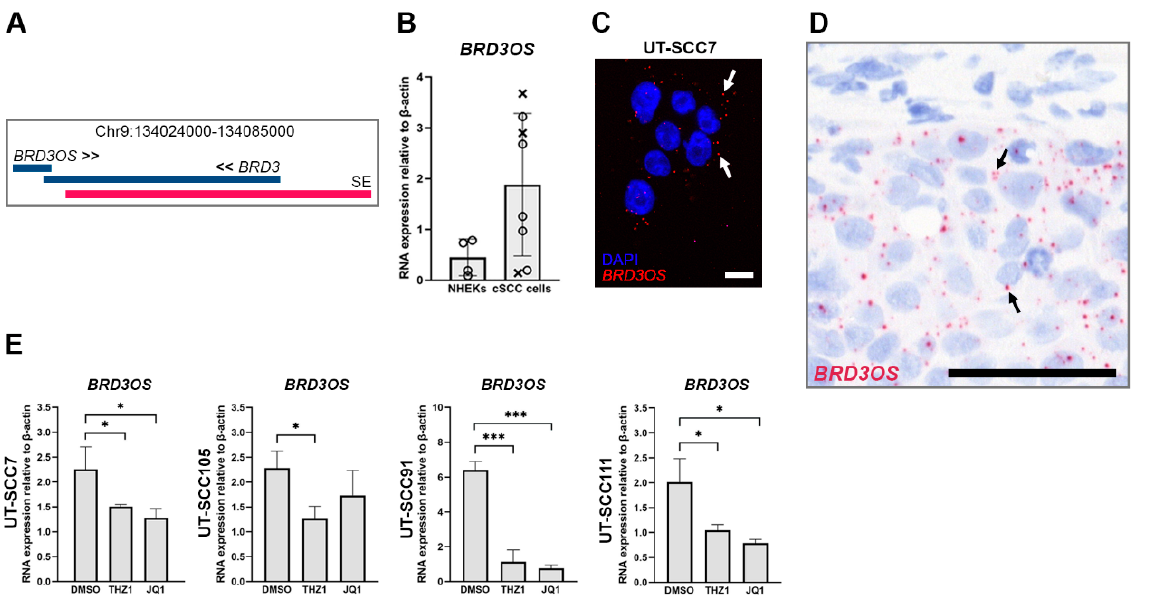
Figure 1. Overexpression of BRD3OS ( LINC00094 ) in cSCC cells is regulated by super enhancer. ( A ) BRD3OS ( LINC00094 ) gene is located near a super enhancer (SE, red bar). ( B ) BRD3OS ( LINC00094 ) expression was measured by quantitative real-time reverse transcriptase PCR (qRT-RCR) in normal human epidermal keratinocytes (NHEKs) ( n = 4) and cSCC cells ( n = 5, primary, round dots; n = 3 metastatic, crosses). ( C ) Expression and cellular localization of BRD3OS ( LINC00094 ) (white arrows) were examined by RNA in situ hybridization (RNA-ISH). Scale bar = 20 µm. ( D ) BRD3OS ( LINC00094 ) expression (black arrows) was determined in cSCC xenograft tumors (UT-SCC7) by RNA-ISH. Scale bar = 50 µm. ( E ): BRD3OS ( LINC00094 ) expression in cSCC cell lines was determined by qRT-PCR 24 h (UT-SCC7 and − 105) or 48 h (UT-SCC91 and − 111) after treatment with THZ1 (100 nM) or JQ1 (5 µM). β -Actin mRNA levels were determined as a reference gene. Mean + SD is shown, * p < 0.05; *** p < 0.001, Student’s t -test.